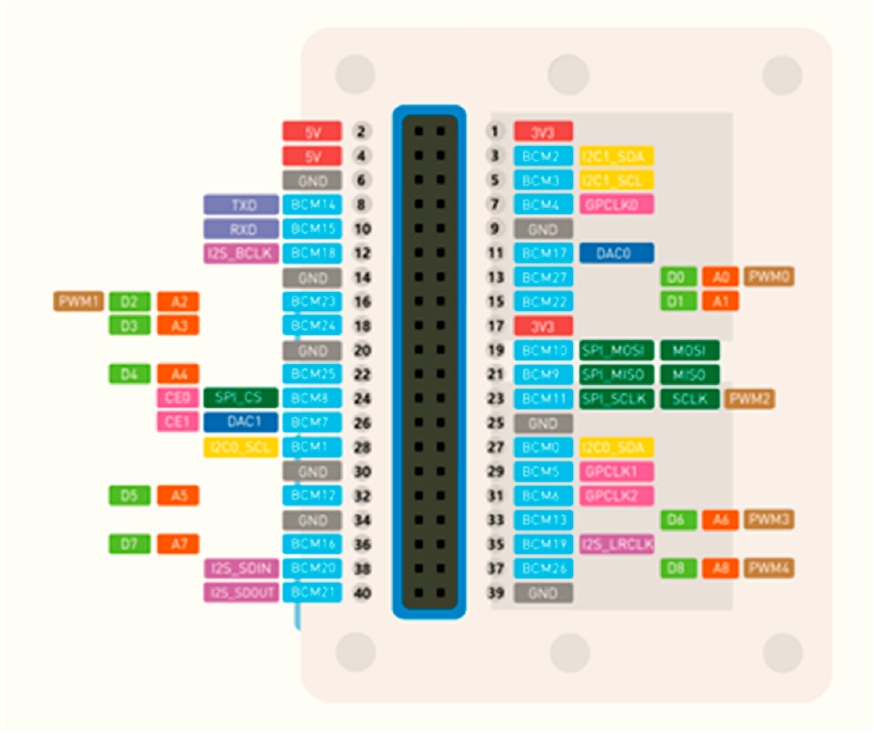
Figure 7. Wio terminal RPI pinout schematic.